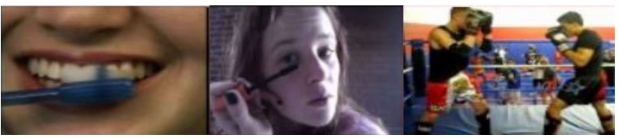
Figure 23. Samples from ActivityNet dataset [233].